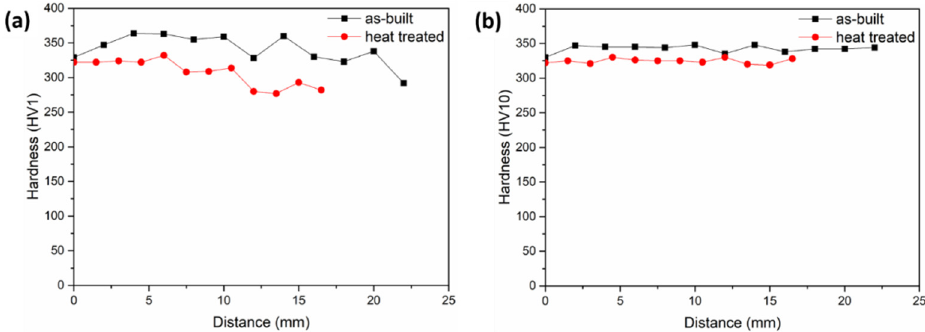
Figure 8. Hardness variation with measurement distance for the as-built and heat-treated samples for ( a ) 1 kg and ( b ) 10 kg loads. Table 6. Chemical composition (in wt.%) of the as-built and heat-treated samples compared to the raw materials.